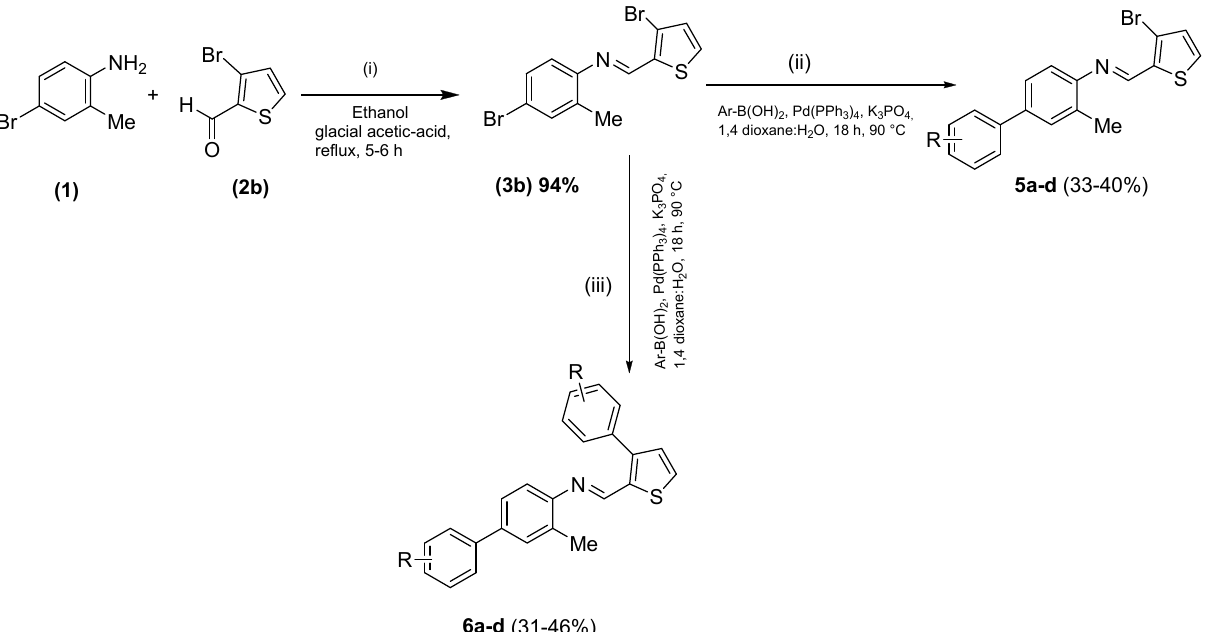
Ethanol glacial acetic-acid,